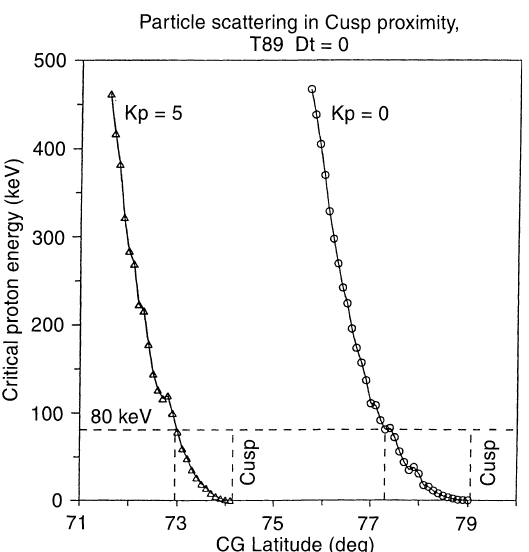
Fig. 1a–d. Results of tracing the mag- netic field lines in T89 model with zero dipole tilt angle. Right panels flank views of magnetic field lines started from a 12 h MLT or b 14 h MLT meridian in the ionosphere with a step 0.1 (cid:176) in latitude. Regions where the condition of isotropic scattering of 80 keV protons ( R / (cid:113) < 8) is fulfilled are c marked by triangles (or asterisks ) for high-latitude cusp region (or nightside equatorial region near the magneto- pause, correspondingly). c Ionospheric projections of isotropic boundaries for 80 keV protons scattered in the high- latitude cusp region ( triangles ) or in the nightside equatorial region ( asterisks ). Position of the last closed field line ( LCFL ) is also shown. d Equatorial mapping of the isotropic boundaries shown on previous plot